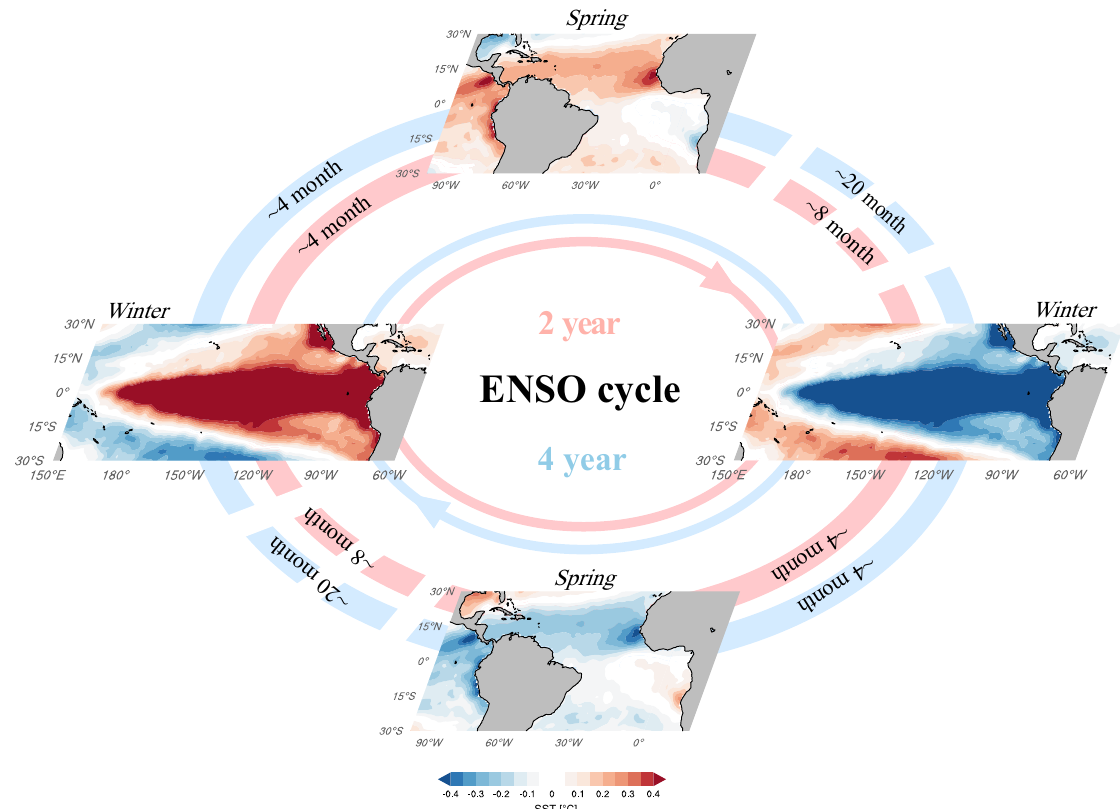
Fig. 4 Schematic trans-basin relationships between tropical Paci fi c and North Atlantic oceans regulated by the ENSO periodicity. In the quasi-biennial ENSO cycle (red loop), an El Niño condition in boreal winter (left panel) leads to positive North Tropical Atlantic (NTA) warming during subsequent spring (upper panel) at a ~4-month lead time, which in turn can see a La Niña formation (right panel) typically following El Niño in the subsequent winter, showing a statistical ~8-month lead time of the NTA. Likewise, a La Niña condition in boreal winter (right panel) gives rise to the following spring NTA sea surface temperature (SST) cooling (lower panel) with a lag of ~ 4 months, which is often followed by an El Niño formation (left panel), corresponding to a statistical ~8-month lead time of the NTA. The same applies for the quasi-quadrennial ENSO cycle (blue loop) except for the negative correlation of NTA SST variability with the following ENSO event by ~20